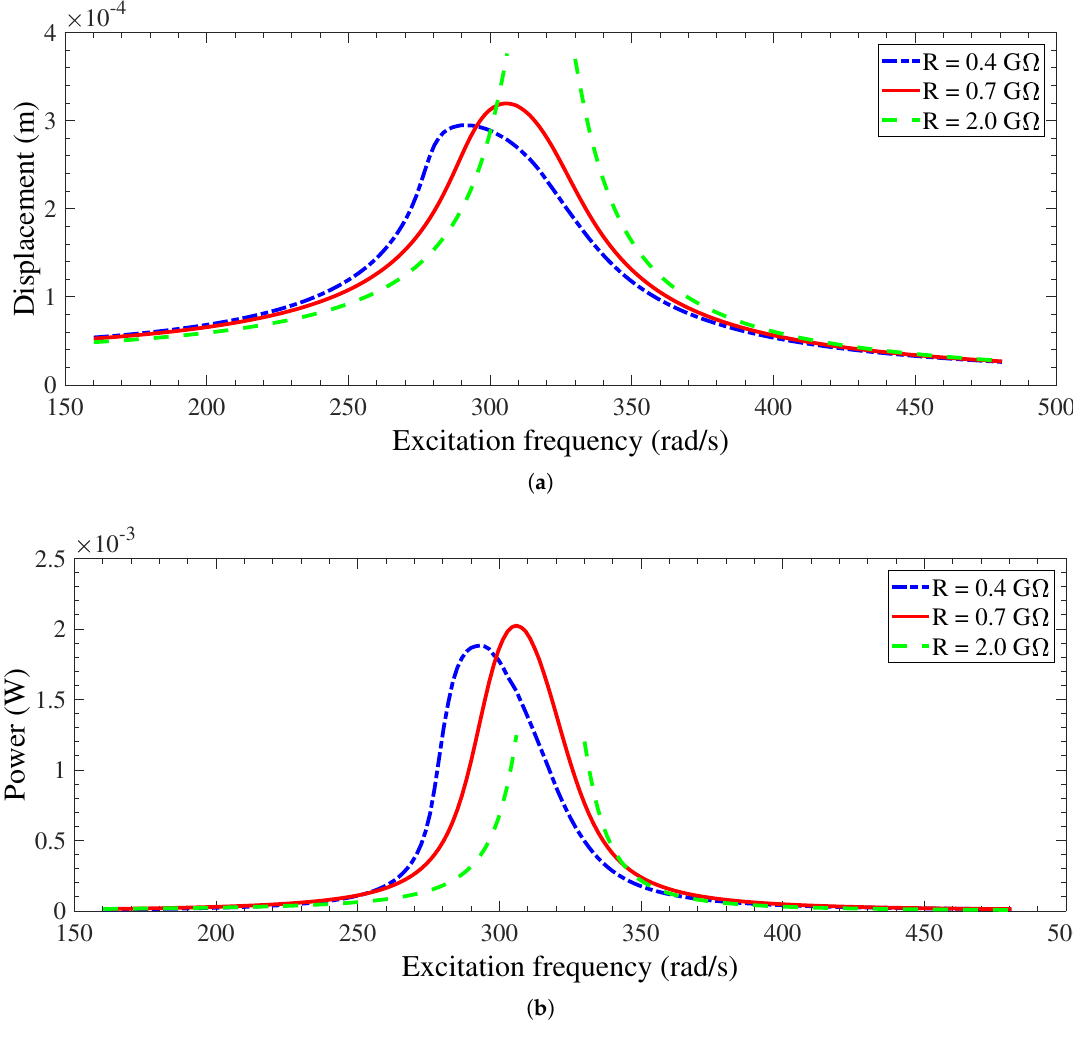
Figure 16. Frequency–response curves in terms of ( a ) displacement and ( b ) electrical harvested power for V et = 2400 V and F = 5 m/s 2 . Table 2. A summary of unlimited responses for different base acceleration and load